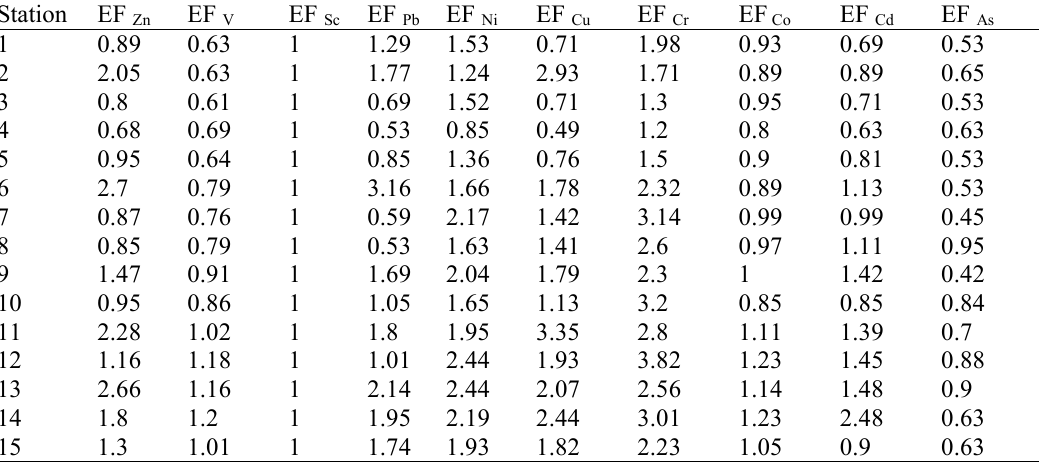
Table 8. Findings based on enrichment factor in soil samples of Kermanshah Refinery, Iran